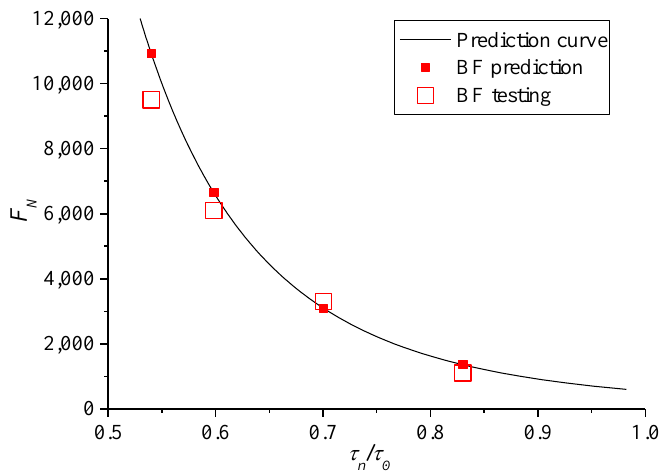
Figure 15. Predicted and experimental F N values for fiber asphalt